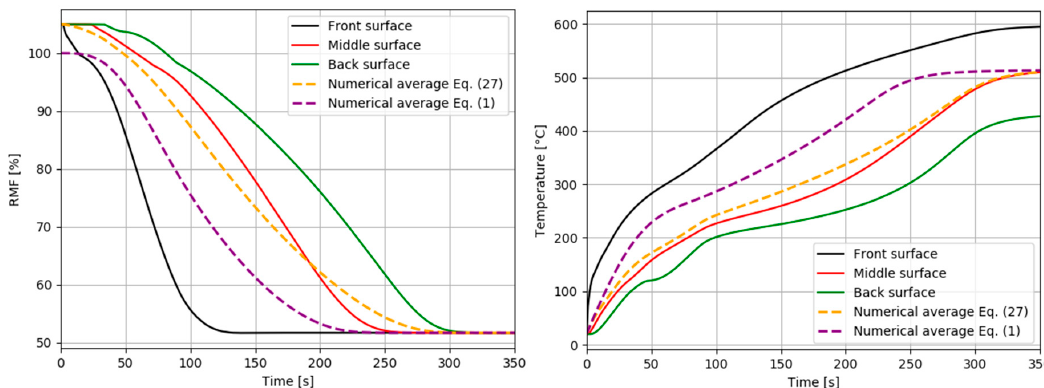
Figure 12. Remaining mass fraction (RMF) profiles and temperature profiles through the material thickness as a function of time. Comparison of numerical simulation prediction as a function of time between thermal and hygro-thermal models for a 3.5 mm thickness E-Glass/polyester composite laminate exposed to a heat flux of 50 kW/m 2.